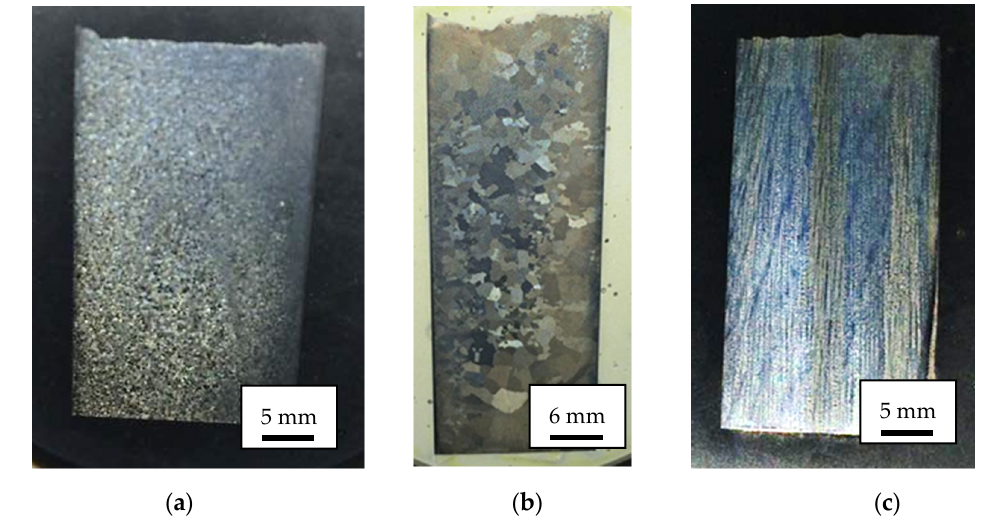
Figure 1. Macroscopic structure of MAR 247 nickel superalloy: ( a ) fine grain, ( b ) coarse grain and ( c ) column grain observed by using light optical microscope. Table 1. Chemical composition of MAR 247 superalloy (wt.